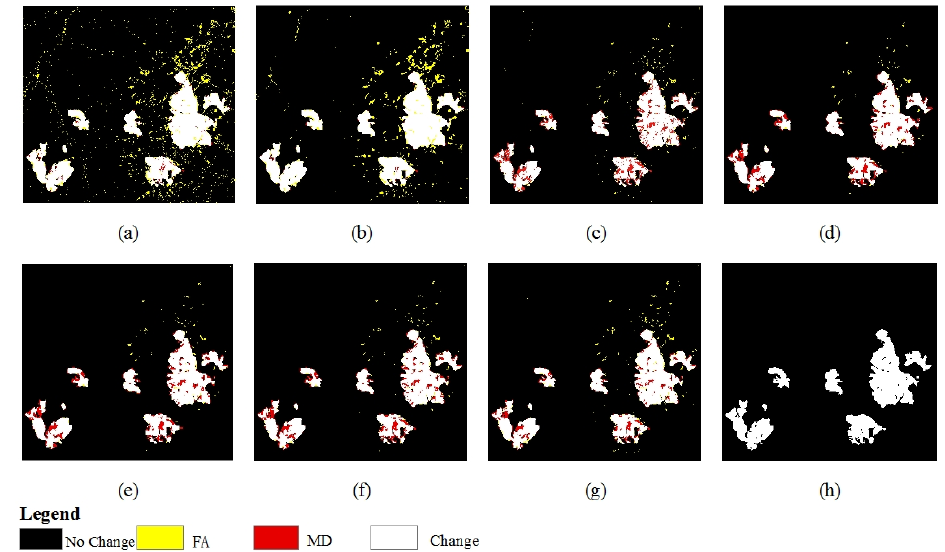
Figure 11. Final change detection maps of the Madeirinha dataset produced by ( a ) EM; ( b ) EMMRF;